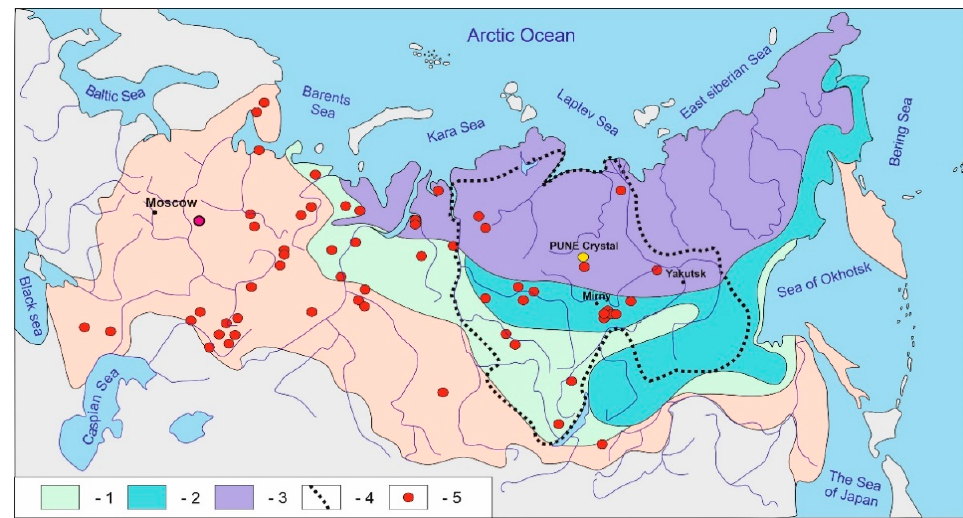
Figure 1. Location of Crystal site (yellow circle). Blue shades show continuous (1), discontinuous (2), and sporadic (3) permafrost. Dotted line (4) contours the Siberian craton. Red circles (5) mark PUNE sites in the former Russian Federation.